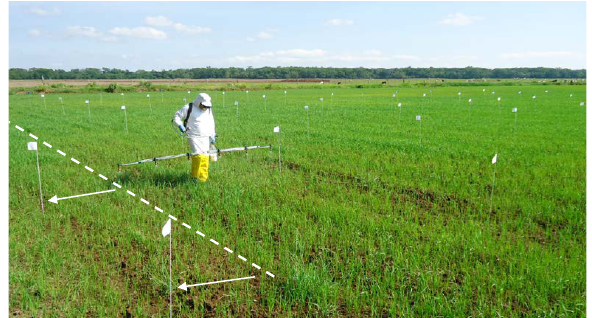
Figure 1. Schematic representation of the application of herbicide treatments in irrigated rice crop, and the control area (a band of 1 m to the right side of all plots) without application in the experimental units.